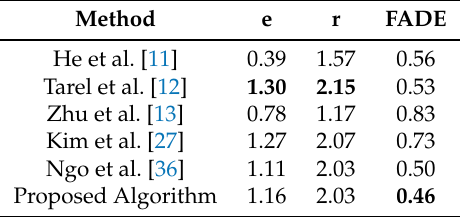
Table 5. Average e, r, and FADE scores on IVC